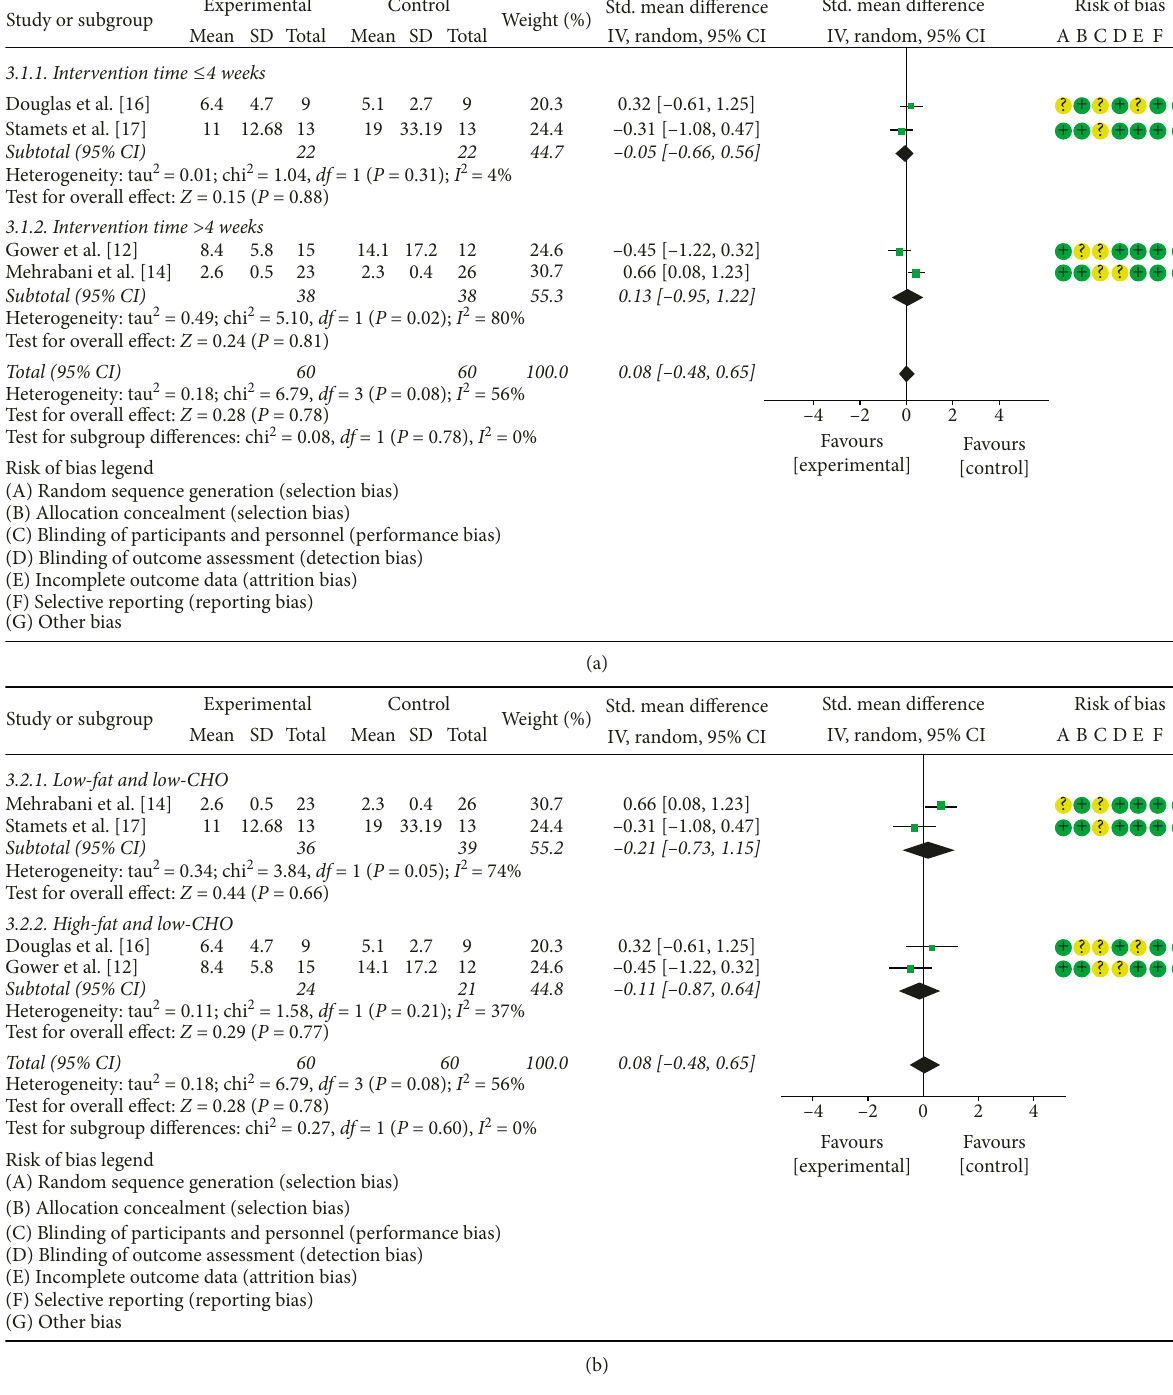
Figure 6: Meta-analysis of the effect of (a) LCD duration on LH levels in PCOS patients and (b) LCD type on LH levels in PCOS